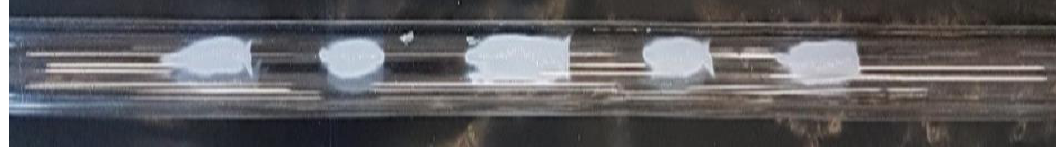
Figure A2. Erosion on the inside of a 4.8 mm (ID) × 7 mm (OD) glass tube after being exposed to the highest amplitude for 2-4 h. The white zones show erosion of glass. Smaller tubes (4 mm OD) hardly showed any erosion.